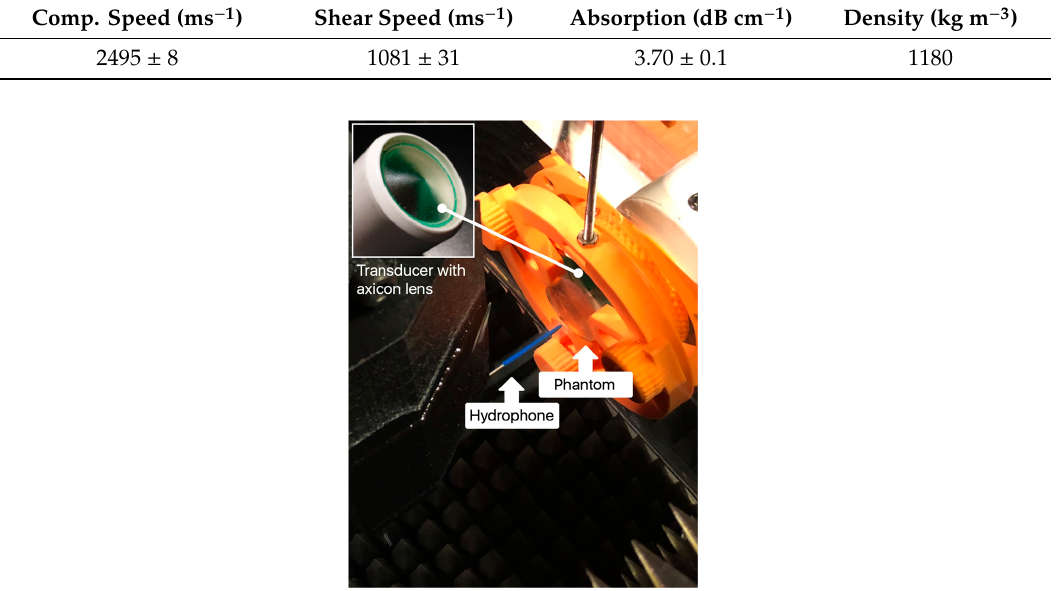
Table 1. Compressional and shear speed, attenuation, and density of Clear Med610 material.